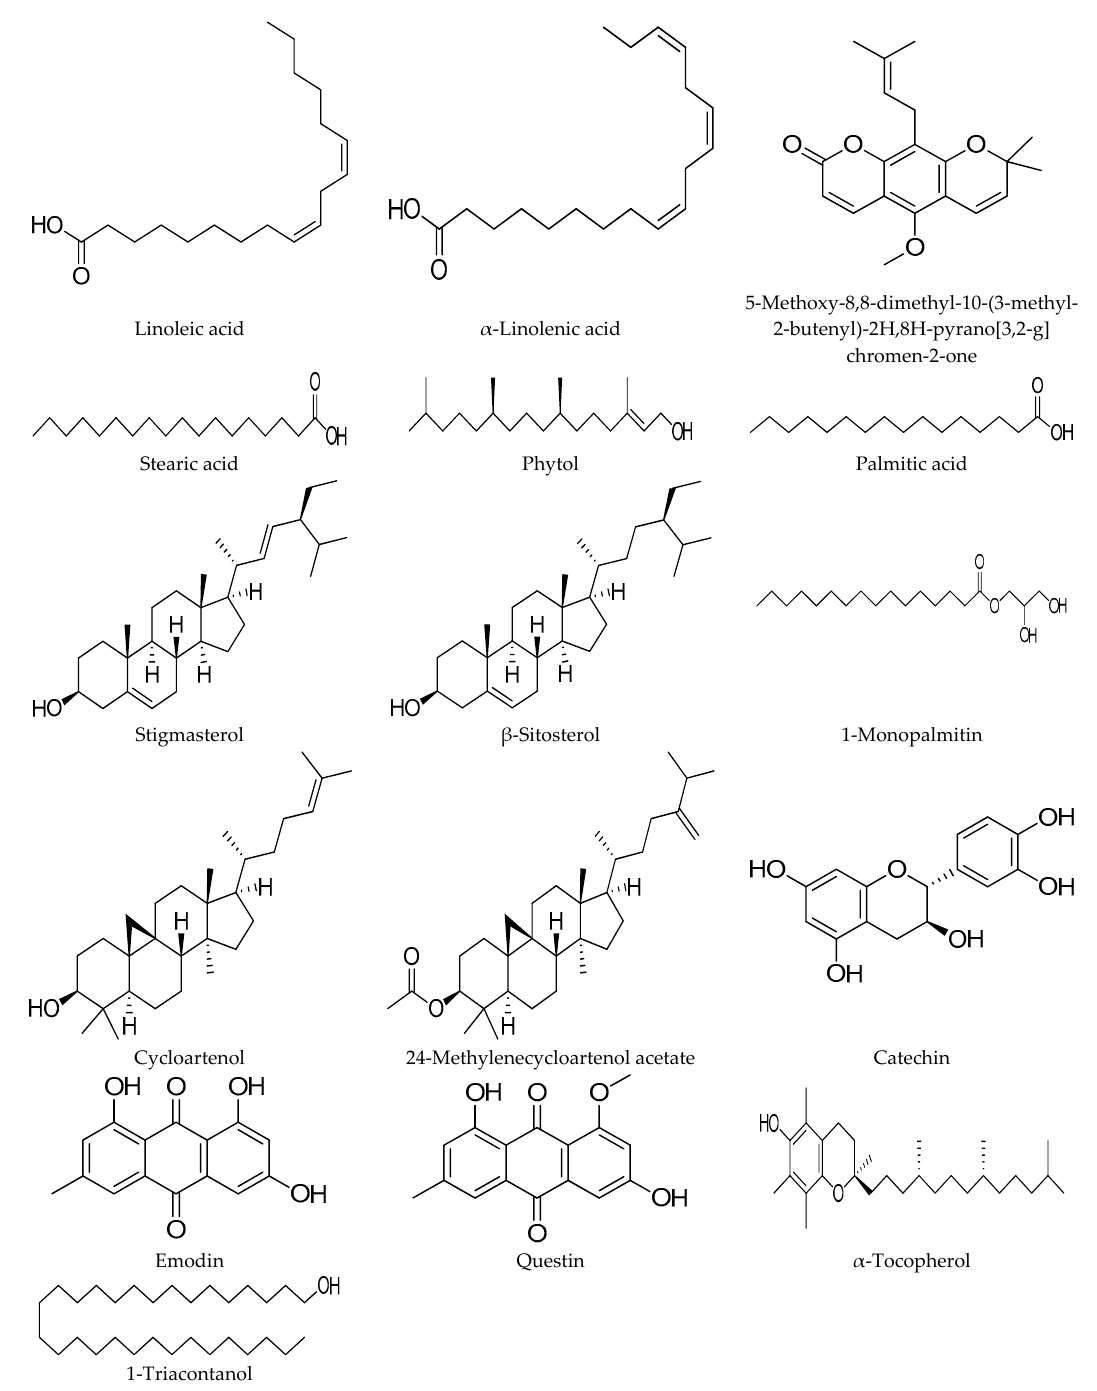
Figure 5. Putative α -glucosidase inhibitory metabolites.